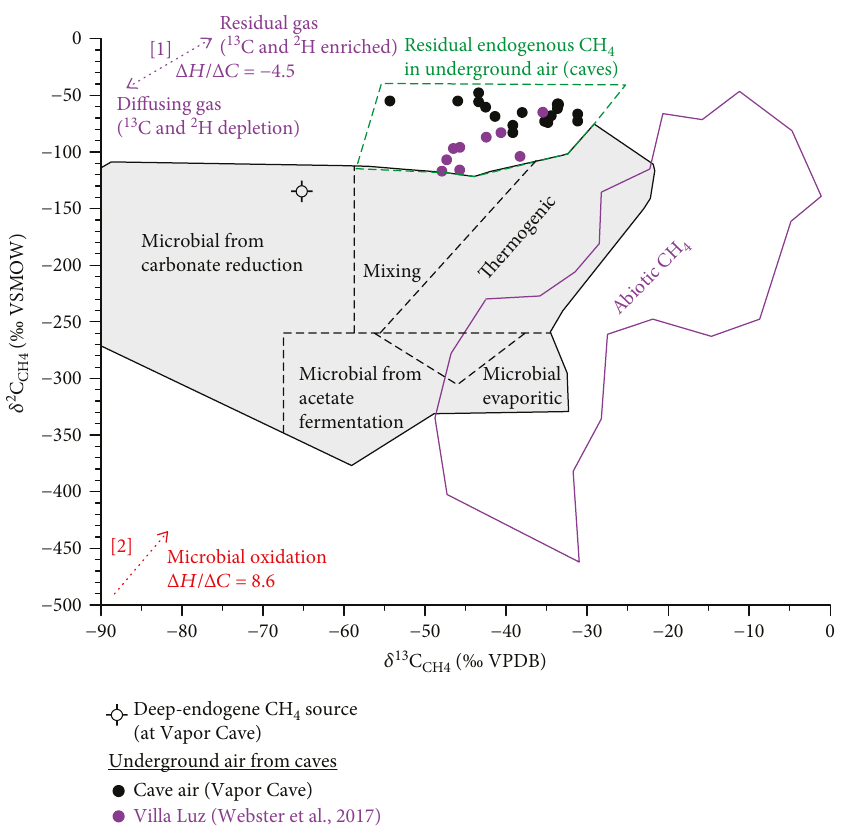
Figure 9: Genetic zonation of CH based on the isotopic composition of carbon ( 13 C/ 12 C) and hydrogen ( 2 H/ 1 H). Proposed genetic zones of 4 (grey zones): thermogenic, microbial from carbonate reduction, microbial from acetate fermentation, and microbial evaporitic, biotic CH 4 compared to the genetic zone for abiotic CH (modi fi ed from [54]). Data pairs of δ 13 C 4 atmosphere, soil air, and underground air of VC in comparison with other published data from hypogenic acid caves [7]. Arrows correspond to two potential postgenetic processes a ff ecting the molecular and isotopic composition of CH its migrations: [A] microbial oxidation and [B] gas di ff